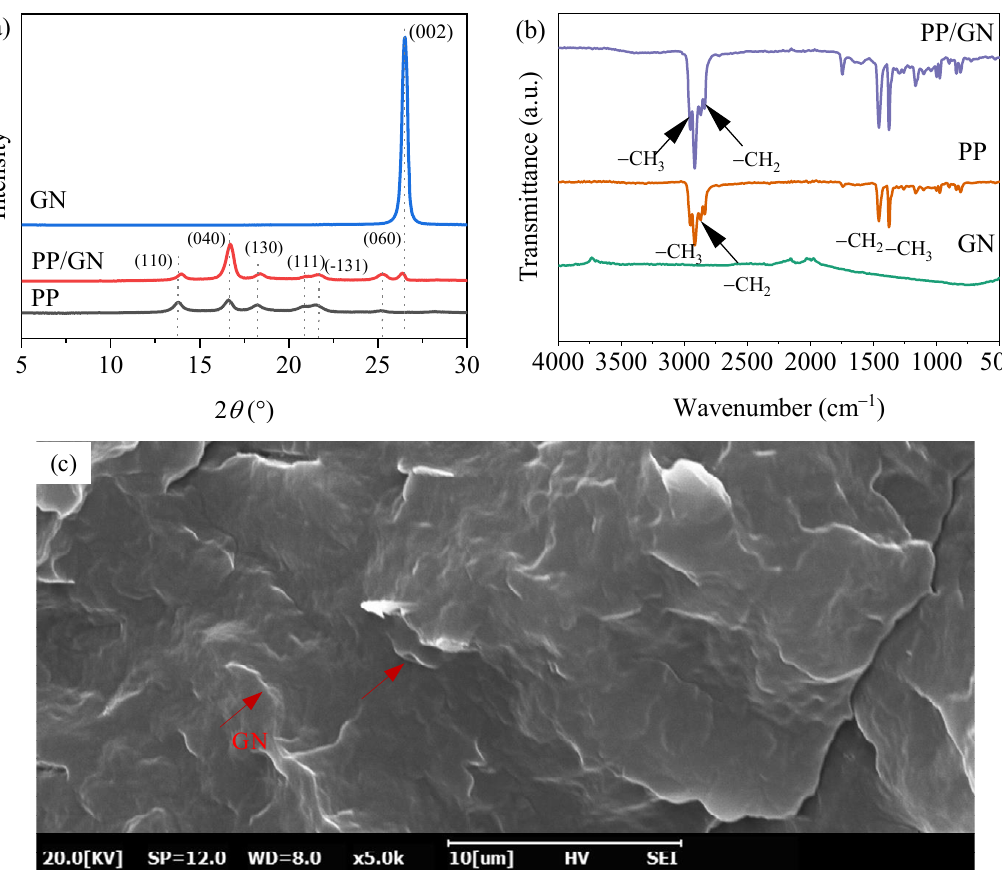
Figure 2. ( a ) XRD patterns of PP and PP/GN nanocomposites, ( b ) FTIR patterns of PP and PP/GN nanocomposites, ( c ) Cross ‐ sectional morphology of PP/GN nanocomposites.